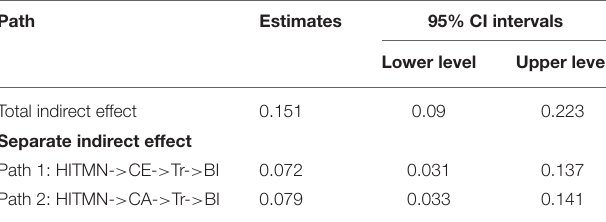
TABLE 4 | Mediation effect estimated by bootstrap methods and 95% CI intervals. Path